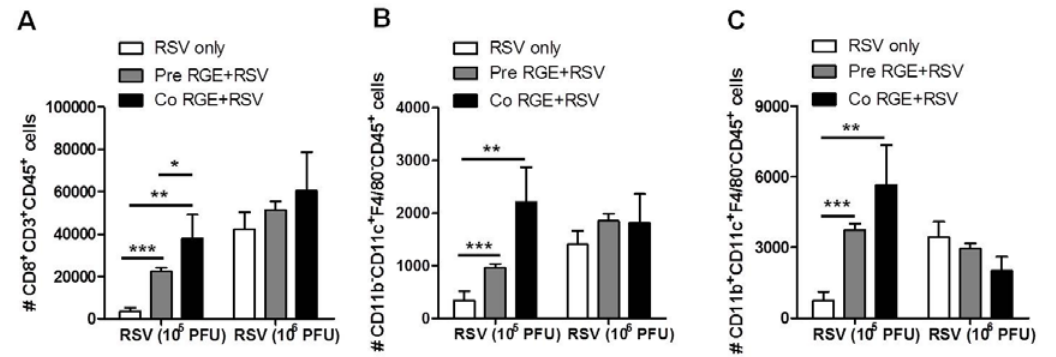
Figure 6. In vivo effects of red ginseng extract (RGE) on phenotypes of bronchoalveolar lavage cells from mice infected with respiratory syncytial virus (RSV). Bronchoalveolar lavage (BAL) was collected five days after RSV challenge, stained with CD45, CD3, CD8α, CD11b, CD11c, and analyzed by flow cytometry. ( A ) CD8 + CD3 + CD45 + T cells; ( B ) CD11b − CD11c + F4/80 − CD45 + dendritic cells; ( C ) CD11b + CD11c + F4/80 − CD45 + dendritic cells. Values are the mean ± SEM. * p < 0.05; ** p < 0.01; *** p < 0.001. RSV only: naïve mice infected with RSV in PBS, Pre RGE + RSV: naïve mice were pretreated intranasally once with RGE (4 mg per mouse) 24 h prior to infection with RSV, Co RGE + RSV: naive mice were once cotreated intranasally with the mixture of RGE (4 mg per mouse) and RSV.